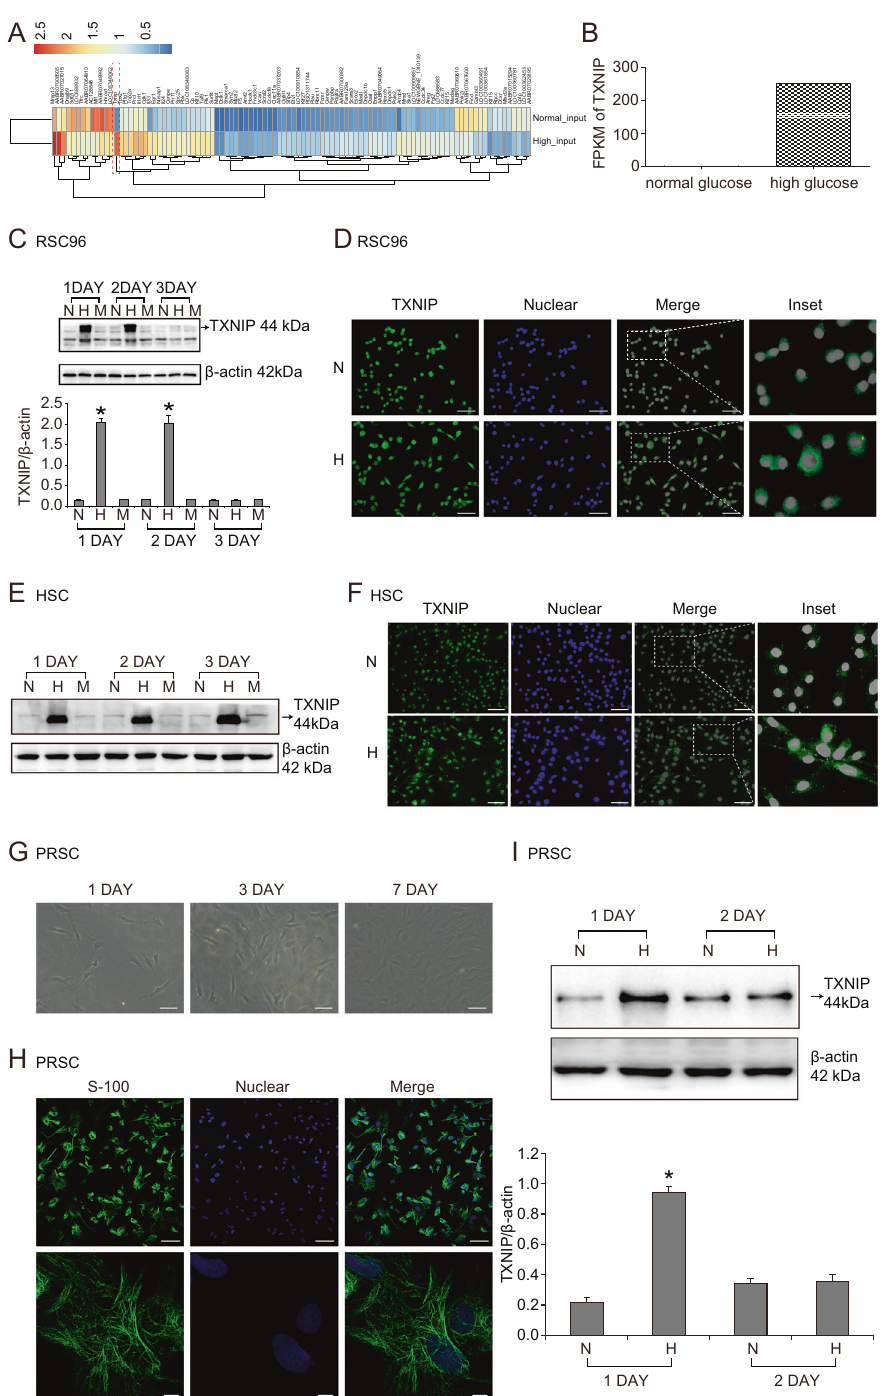
Fig. 2 High glucose increased TXNIP expression in RSC96 cells, HSC cells and PRSC cells. A RNA-seq results of the main differential expression genes (DEGs) in RSC96 cells treated with normal glucose or high glucose for 48 h. B Fragments per kilobase of transcript per million fragments mapped (FPKM) of TXNIP in RSC96 cells stimulated with normal glucose or high glucose. C Western blot and statistical analysis of TXNIP expression in RSC96 cells of normal glucose group (5.5 mmol/L glucose, N), high glucose group (25 mmol/L glucose, H) and mannitol group (25 mmol/L mannitol, M) at the indicated time point. * P < 0.05 versus N group. D Immuno fl uorescence of TXNIP in RSC96 cells treated with normal glucose (N) and high glucose (H). The inset was shown with dashed rectangle. Bar: 50 μ m. E Western blot of TXNIP expression in HSC cells of normal glucose group (5.5 mmol/L glucose, N), high glucose group (25 mmol/L glucose, H) and mannitol group (25 mmol/L mannitol, M). F Immuno fl uorescence of TXNIP in HSC cells treated with normal glucose and high glucose. The inset was shown with dashed rectangle. Bar: 50 μ m. G The invert microscope observation of primary rat Schwann cells (PRSC) growth. Bar: 50 μ m. H The identi fi cation of PRSC cells by immuno fl uorescence detection of Schwann cells biomarker S-100. Bar: 50 μ m. I Western blot and statistical analysis of TXNIP expression in PRSC cells treated with normal glucose and high glucose. * P < 0.05 versus N